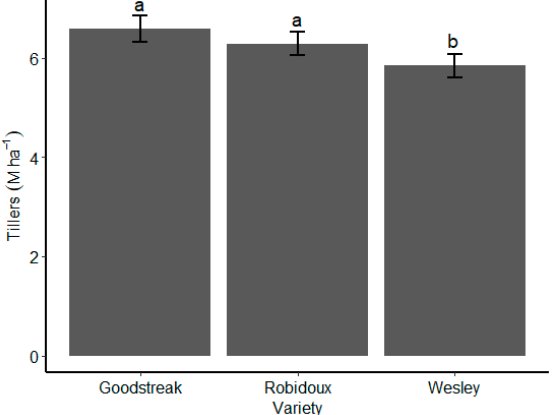
Figure 9. The effect of variety on the number of tillers produced at Hemingford. The error bars represent the standard error of the mean. The unit is expressed in million ha − 1 . Different letters on top of column bars indicate a significant mean difference at p < 0.05.